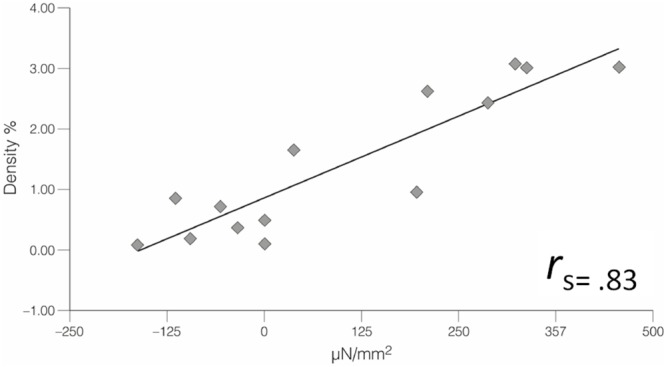
The MFB density of several samples of rat lumbar fascia was assessed (via immunostaining for ASMA) subsequent to their mechanographic examination in an organ bath environment. Statistical analysis revealed a strong positive correlation between the two factors, where higher MFB density was associated with more forceful contractile response (n = 14).